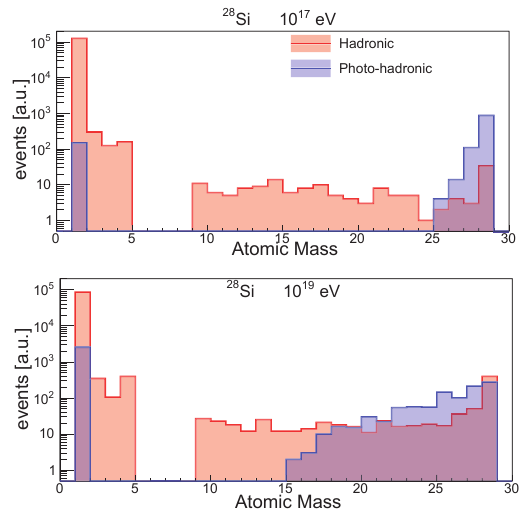
Figure 4. Mass distributions of nuclei escaping from the proto- type SBG, for primary Silicon nuclei with energies 10 17 (top) and 10 19 eV (bottom panel). The blue (red) histogram refers to the propagation in the source when only photo-hadronic (hadronic) interactions are